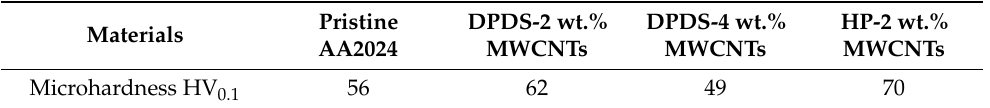
Table 1. Vickers micro-hardness values of pristine AA2024 and several AA2024-MWCNTs composites produced under different